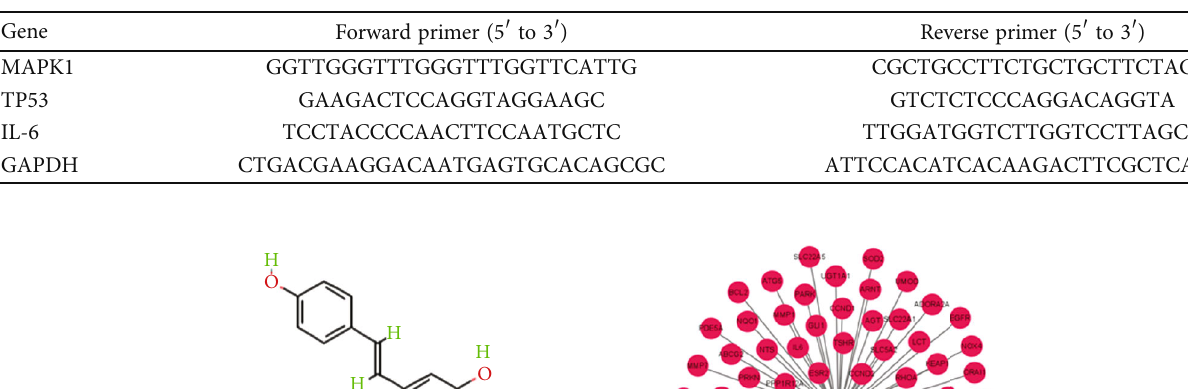
Table 1: Sequences of primers used quantitative real-time PCR.